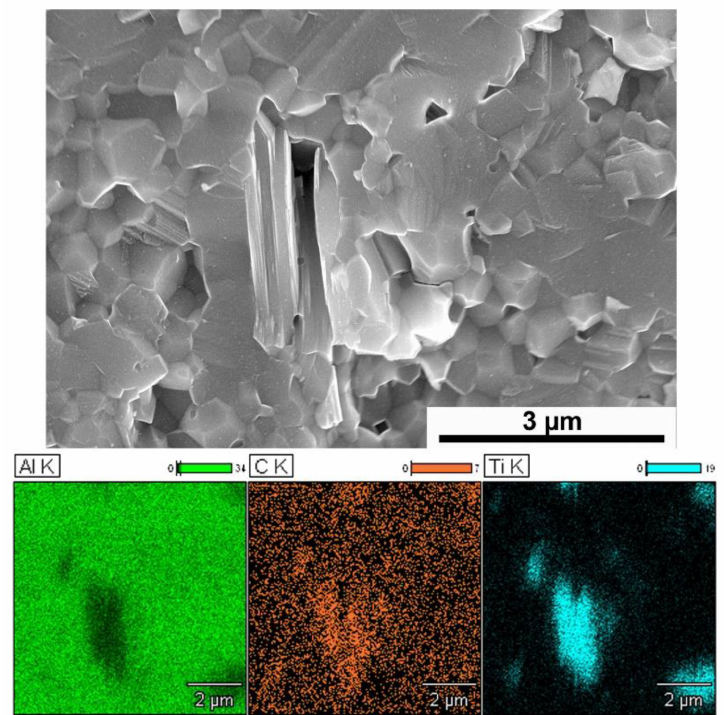
Figure 5. The EDS (Energy-dispersive X-ray spectroscopy) elemental map of Al 2 O 3 —5wt% of Ti 3 AlC 2 composites.